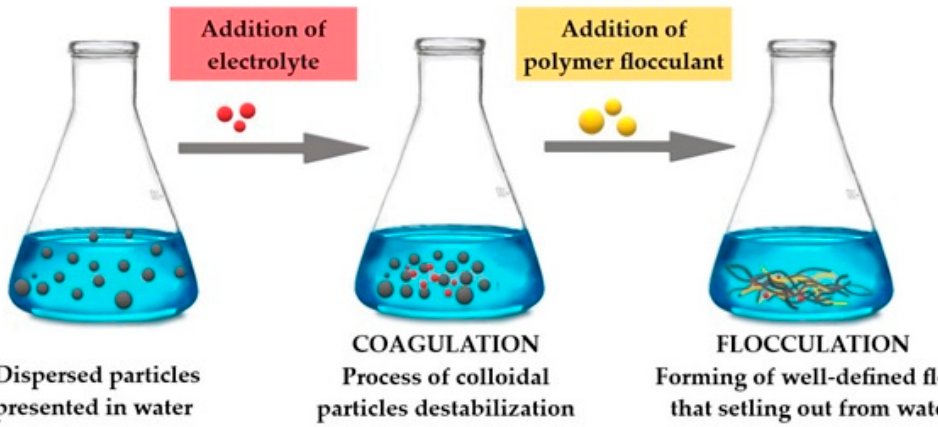
Figure 1. Illustration of coagulation and flocculation process.